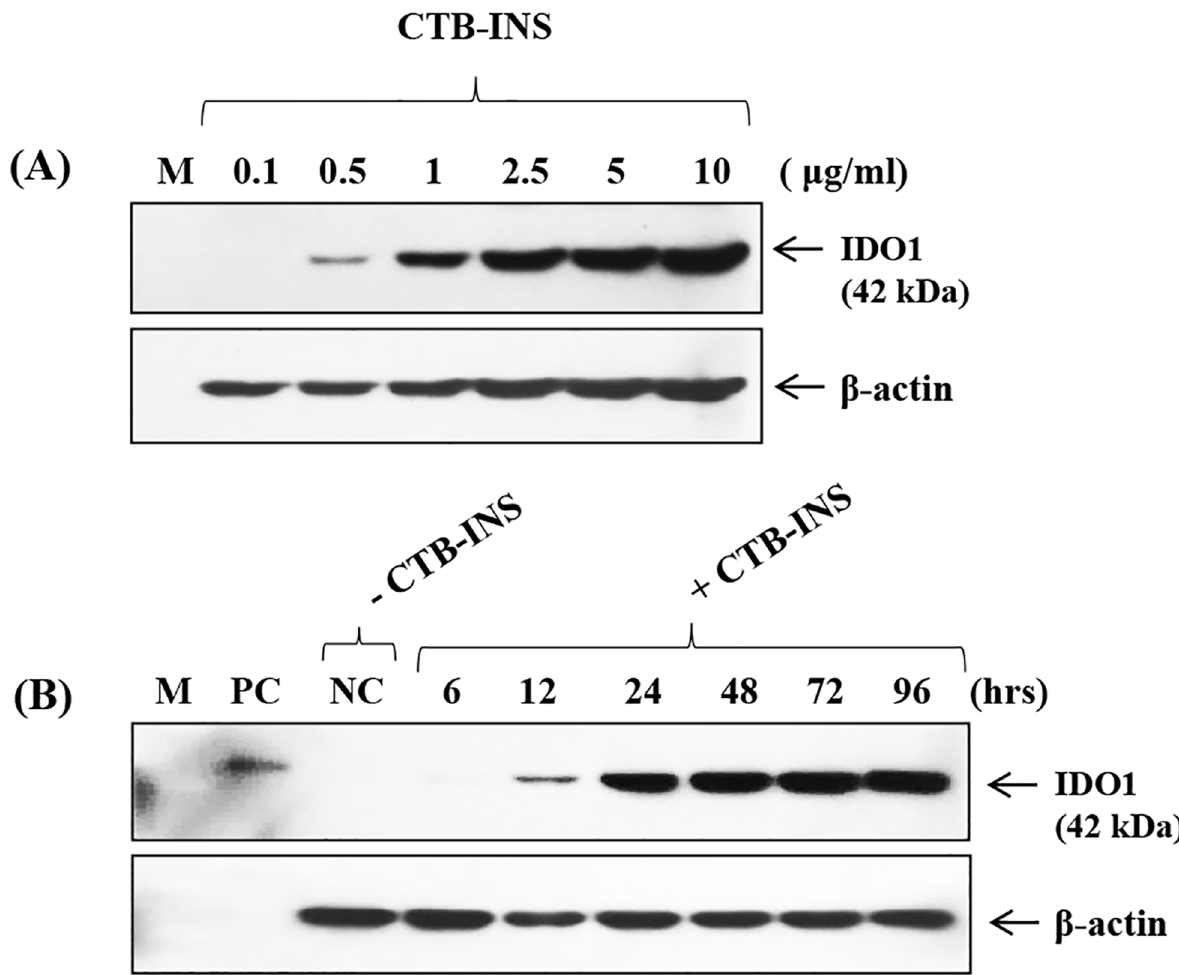
Fig 2. IDO1 Expression with varying concentrations of CTB-INS and incubation times and conditions. In panel (A) varying concentrations of CTB-INS from 0.1 to 10 μ g/ml were used to assess the minimal concentration of CTB-INS needed to cause detection of IDO1 in monocyte-derived DCs. In Panel (B) monocyte-derived DCs were incubated with CTB-INS for 6 hrs to 96 hours with the medium changed every 2 days. IDO1 expression went increasingly unabated for 96 hours. M: Marker. PC: Positive Control (IDO1 recombinant protein) NC: Negative Control (Untreated).